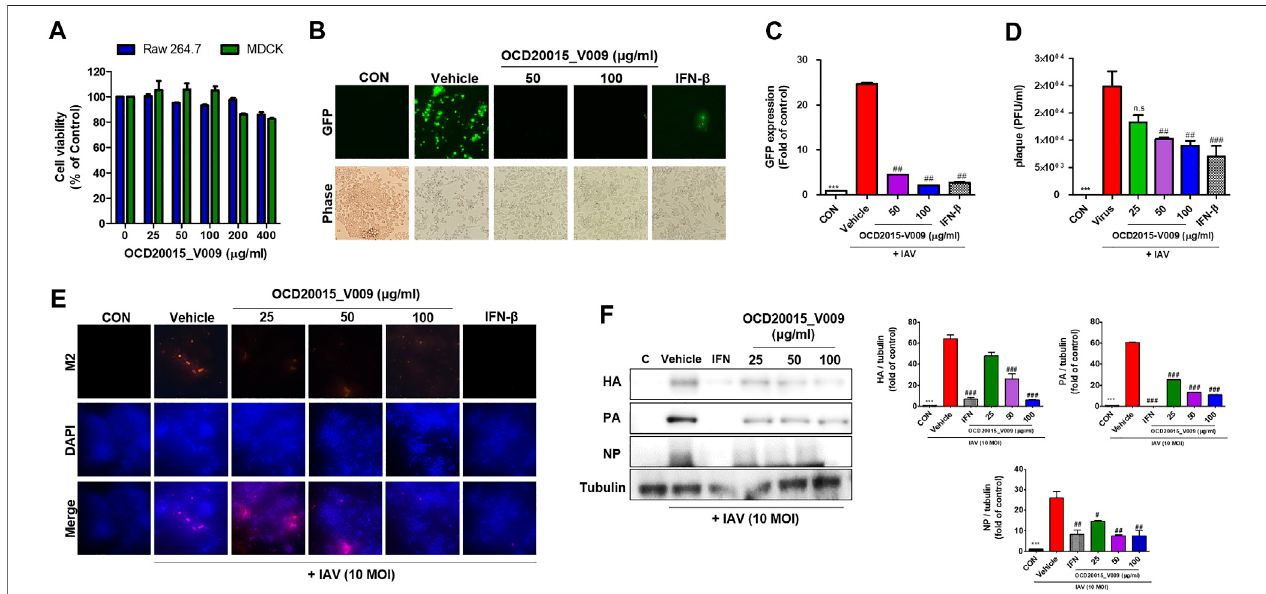
FIGURE 1 | The antiviral effect of OCD20015-V009 pre-treatment on the in fl uenza A virus infection of RAW 264.7 murine macrophages. (A) Determination of the effective cytotoxic concentration of the OCD20015-V009 in RAW 264.7 and MDCK cells. Cell viability after 24 h ( n (cid:2) 3 each) was determined using the MTT assay. (B) RAW264.7cellsweretreatedwithOCD20015-V009beforeIAVinfection.Thecellswereincubatedwithonlyamedium,50and100 μ g/mlOCD20015-V009,or1000U/ mL recombinant mouse interferon- β for12 h before infection withA/PR/8/34-GFPat amultiplicity ofinfection of10. Images ofGFP production wereobtained24 h after virus infection. (C) The GFP levels and reduction in viral replication were assessed using fl ow cytometry 24 h after viral infection in the OCD20015-V009-treated RAW264.7cells.Thedataarepresentedasthemean ± SD(errorbars)ofthreeindependentexperiments.*** p < 0.001comparedwiththecontrol,## p < 0.01compared withthevehicle(IAV-infection) (D) EffectsofOCD2015-V009treatmentonA/PR/8/34infectionandviralgrowthinplaquesinMDCKcells. (E) ThereductionofM2inRAW 264.7 cells was observed with fl uorescence microscopy using an M2-speci fi c antibody. RAW 264.7 cells were stained with DAPI (blue), and the merged images representM2(red).RAW264.7cellswerepre-treatedwith25,50or100 μ g/mlOCD20015-V009,1000U/mLrecombinantmouseinterferon(IFN)- β ,oronlythemedium (negativecontrol)beforeviraladsorption. (F) Thelevelsofin fl uenzaAvirusproteinsHA,PA,andNPincelllysateswereanalyzedbyWesternblots,andtheleveloftubulin was used as internal control. Western blotting of viral expressions followed by quanti fi cation using the ImageJ software was performed. The data are presented as the mean ± SD (error bars) of three independent experiments. ** p < 0.01 indicates a signi fi cant difference between control groups, # p < 0.05 and ## p < 0.01 indicates a signi fi cant difference between the vehicle (IAV-infection) groups. n.s., not signi fi cant, compared with the